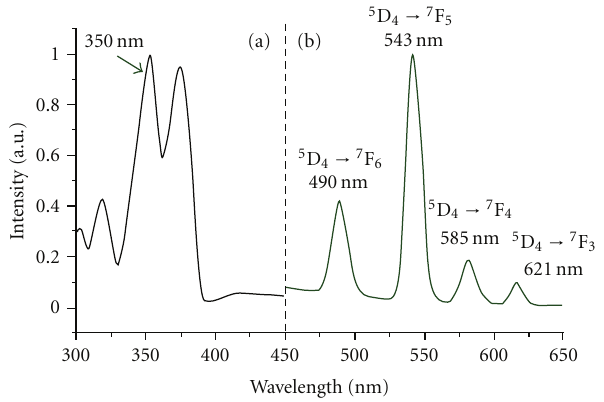
Figure 9: Characteristic (a) excitation spectrum ( λ em = 542 nm) and (b) emission peaks of Tb 3+ : LaF 3 ( λ ex = 375 nm) [23].